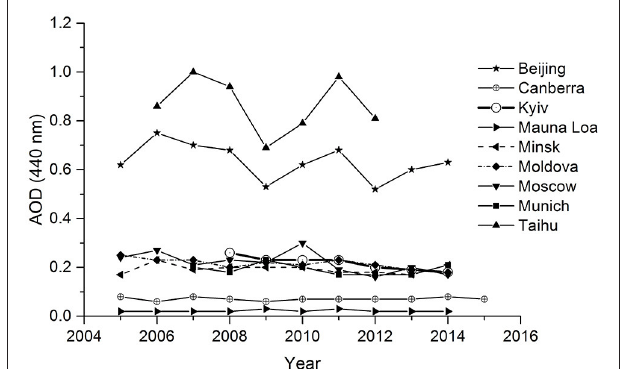
FIGURE 3 | Comparison of aerosol amount by AERONET measurements over various sites over the